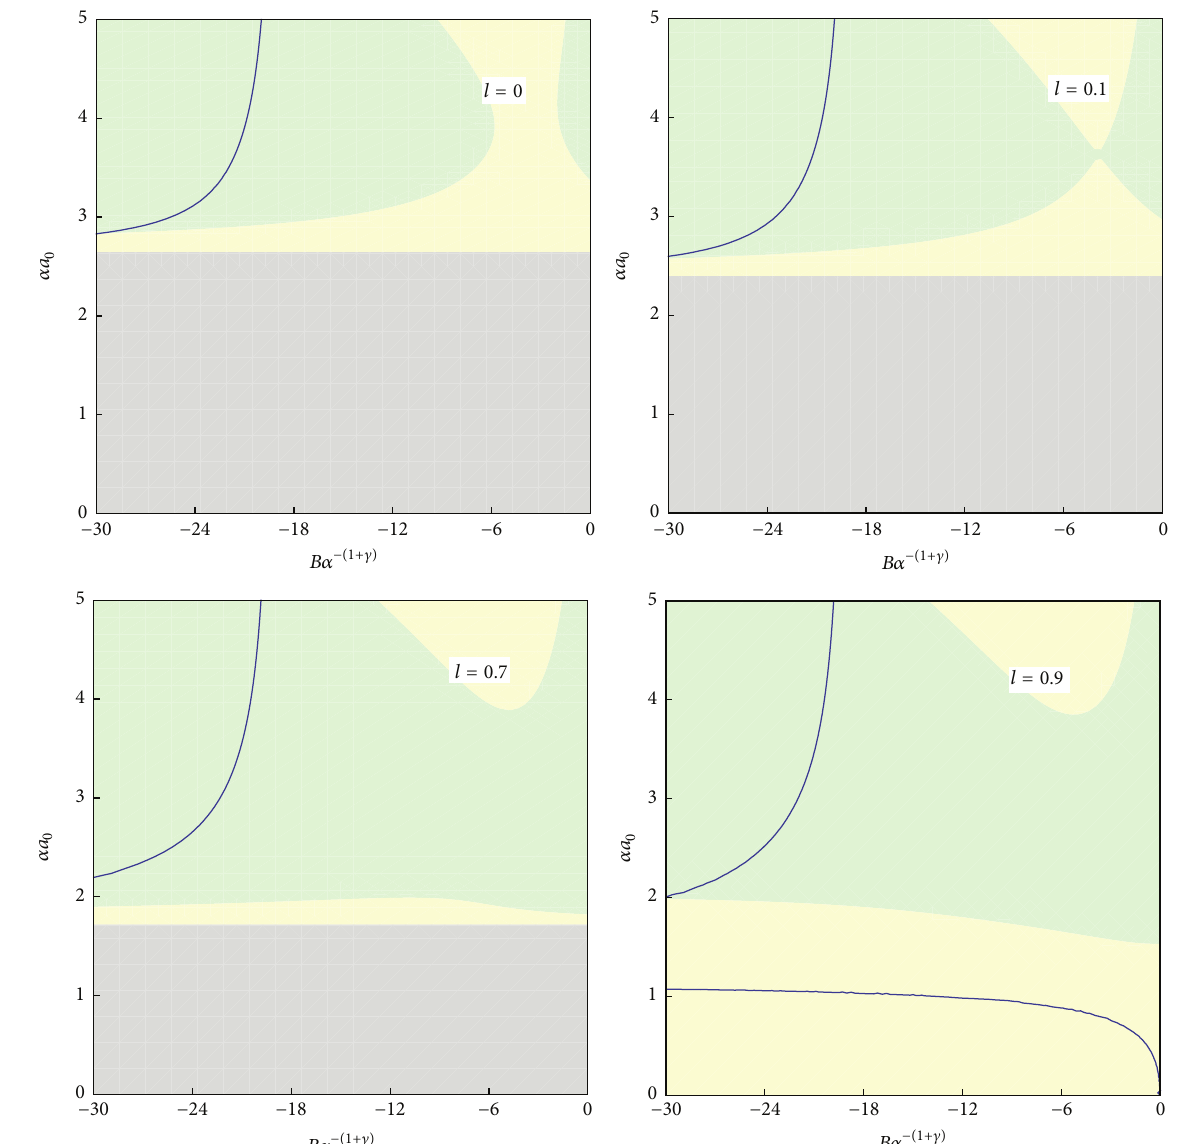
Figure 4: Plots for VDW quintessence EoS taking 𝛾 = 1 , 𝑀 = 1 , 𝛼 = 1 , and different values of Hayward parameter 𝑙